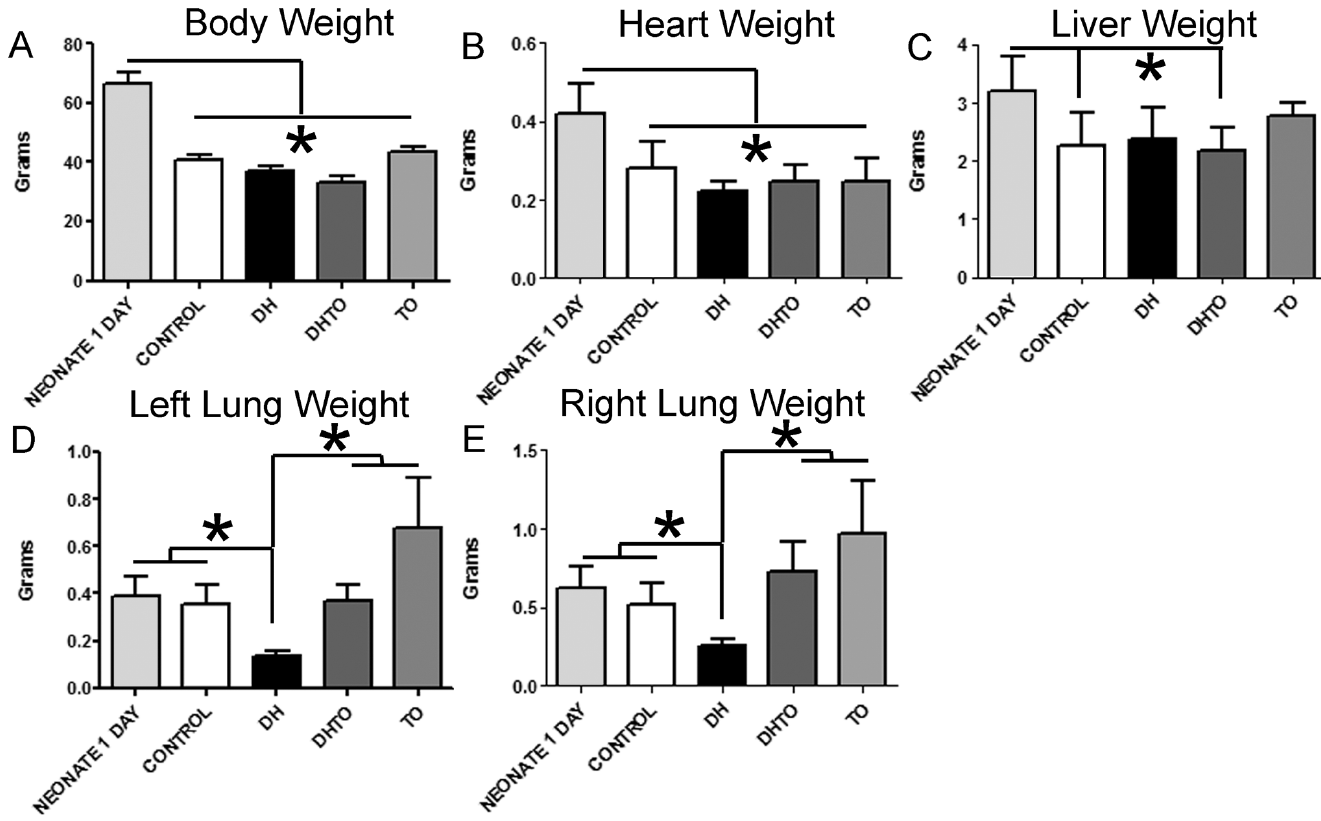
Figure 3. Organ and body weights in DH and DHTO. (A) DH and TO surgeries did not result in any significant difference in fetal body weight, (B) fetal heart weight, or (C) fetal liver weight. (D) DH resulted in a decrease in left lung weight compared with all other groups. TO alone resulted in a left lung that was larger than all other groups (not shown for clarity purposes). (E) DH induced similar changes in the right lung as the left. Right lung weight in TO alone was significantly greater than d 1, control and DH lung (not shown for clarity